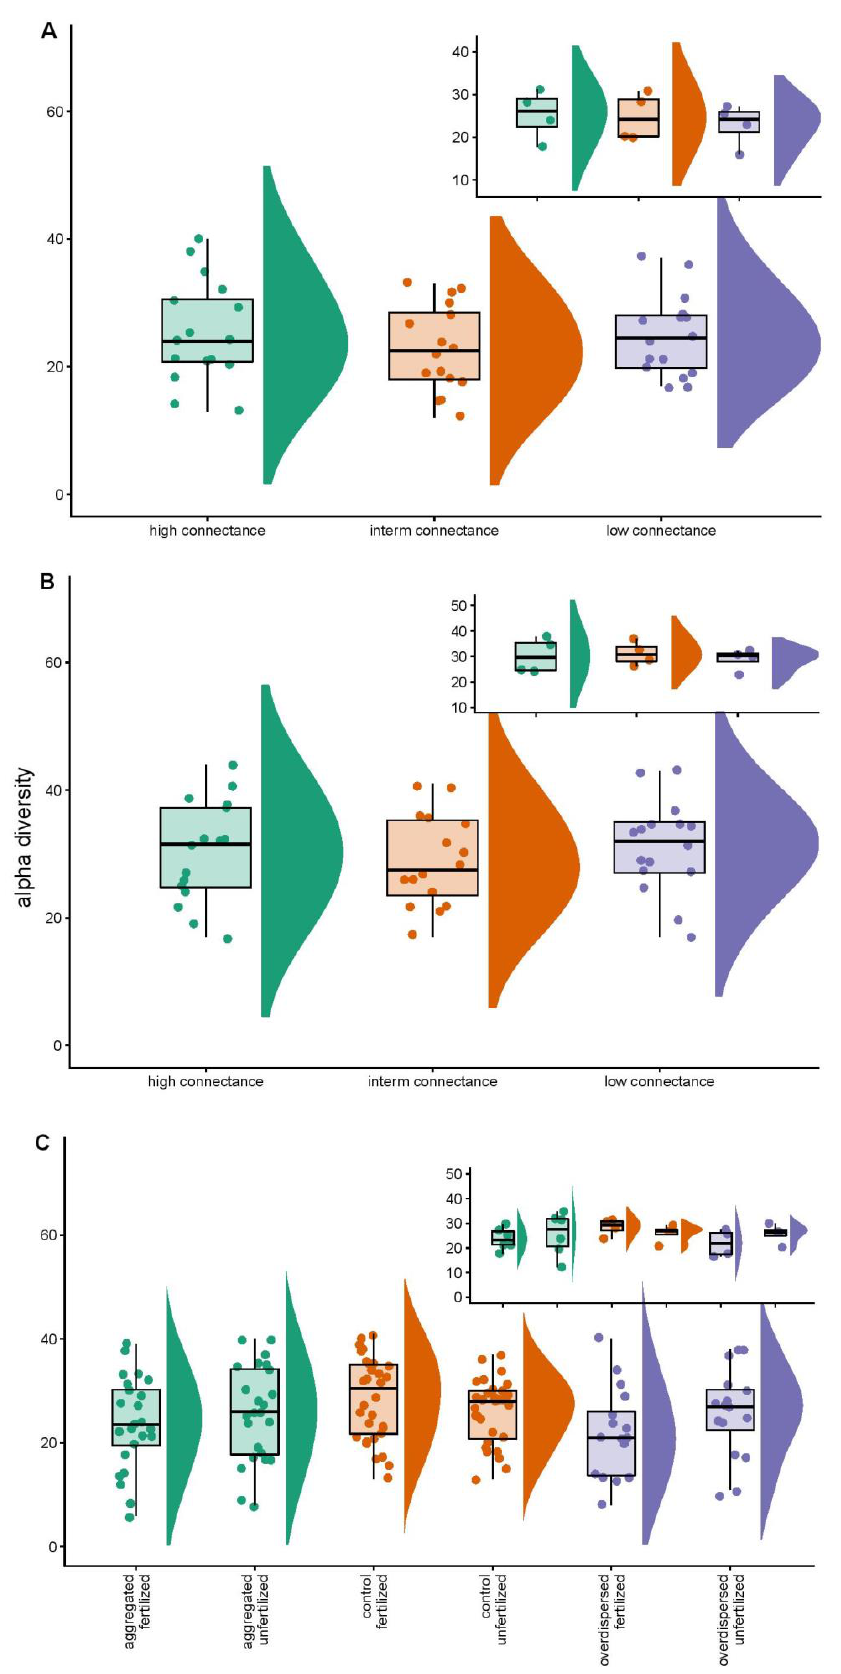
Figure 2. Alpha diversity statistics across treatments and habitats in ( A ) Experiment